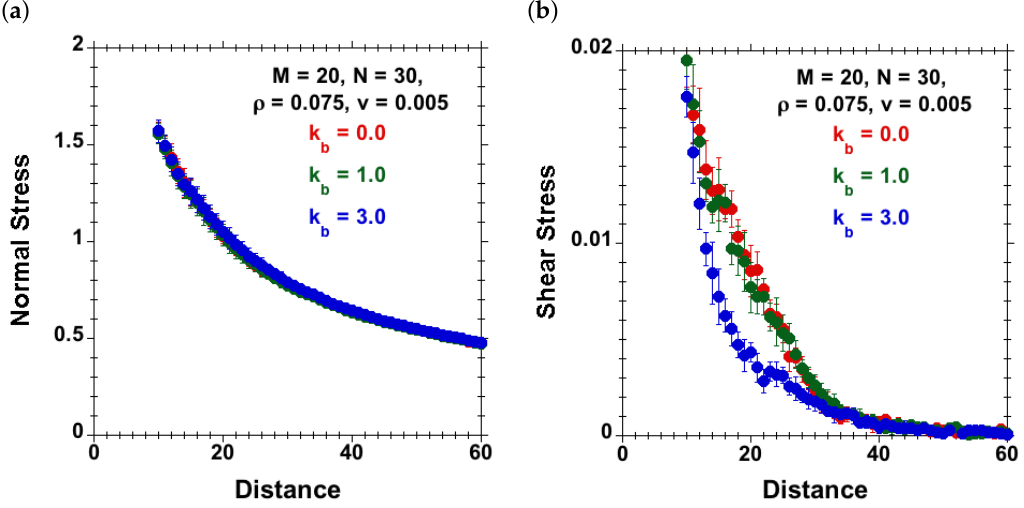
Figure 10. Steady-state ( a ) normal stress and ( b ) shear stress against separation for brush-against-brush systems ( M = 20, N = 30, good-solvent conditions, ρ = 0.075) subjected to shear velocity v = 0.005 for chains with varying stiffness: k b = 0 (red), k b = 1 (green) and k b = 3 (blue). For intermediate